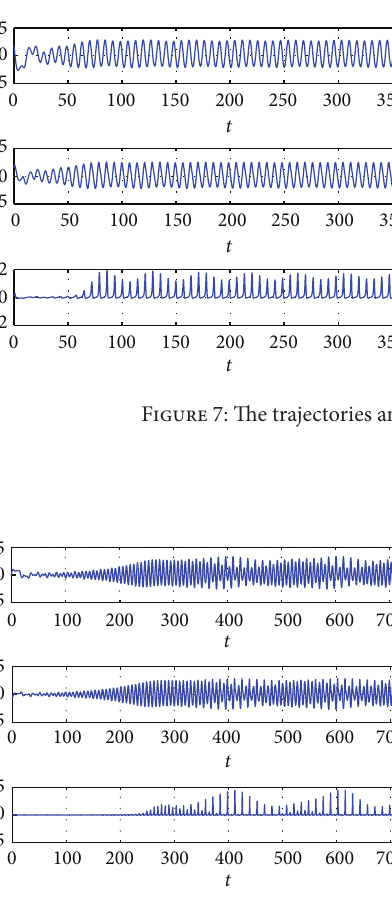
Figure 8: The trajectories and phase graphs of system (61) with 𝜏 = 13.7423 when 𝐾 = −1